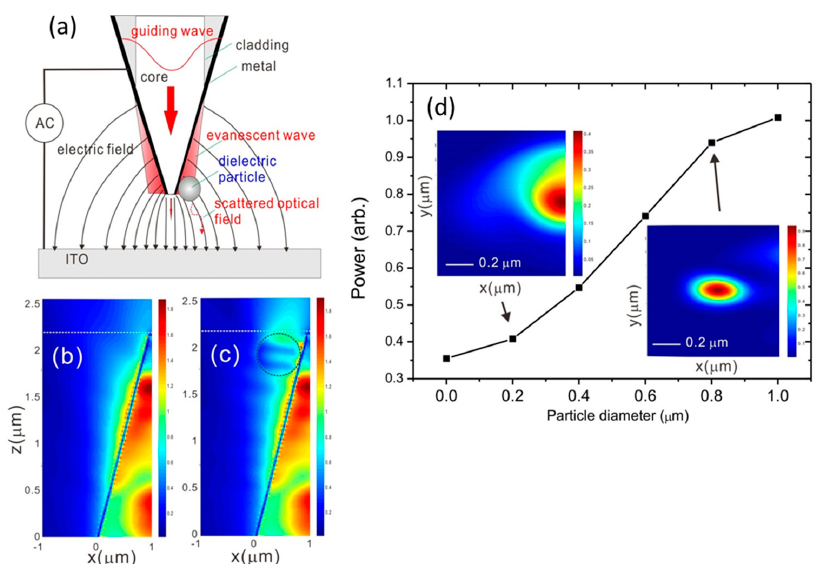
Figure 1. ( a ) The illustration of the detection principle; ( b , c ) The calculated optical fields without and with a micron sphere at the tip. The diameter of the sphere is 0.4 μ m; ( d ) The optical power as a function of particle size. The inset shows the optical fields ( x - y plane) at the tip end as indicated by dashed white lines in Figure